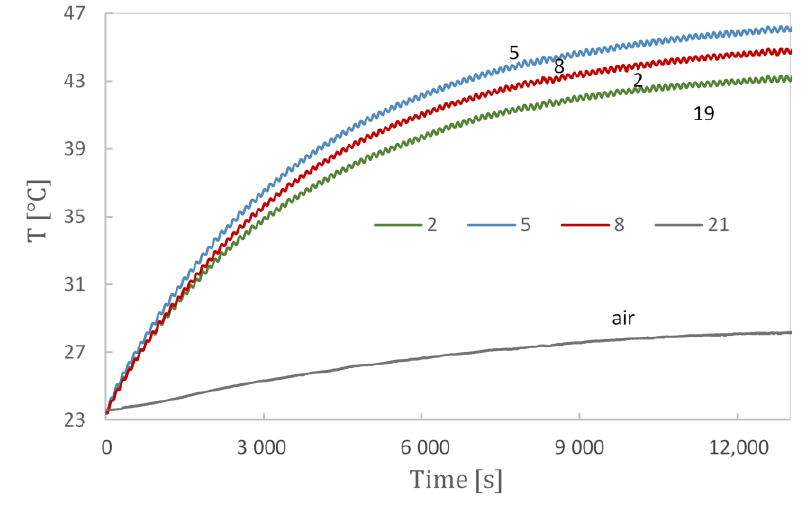
Figure 8. Evolution of T2, T5, T8, and T19 as a function of time at 40 A. Effect of the